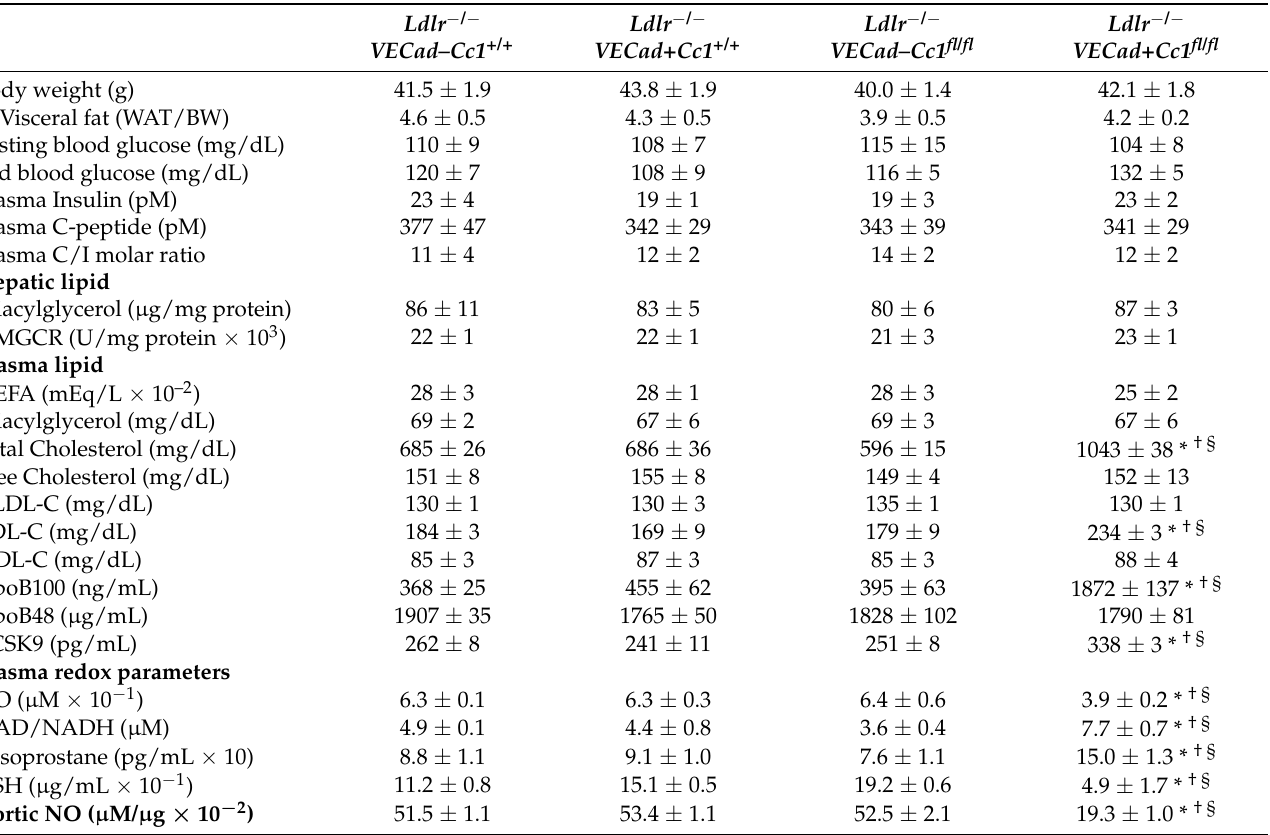
Table 1. Plasma and tissue biochemistry in 9-month-old mice propagated on Ldlr − / − background and fed an atherogenic high cholesterol diet in the last 3